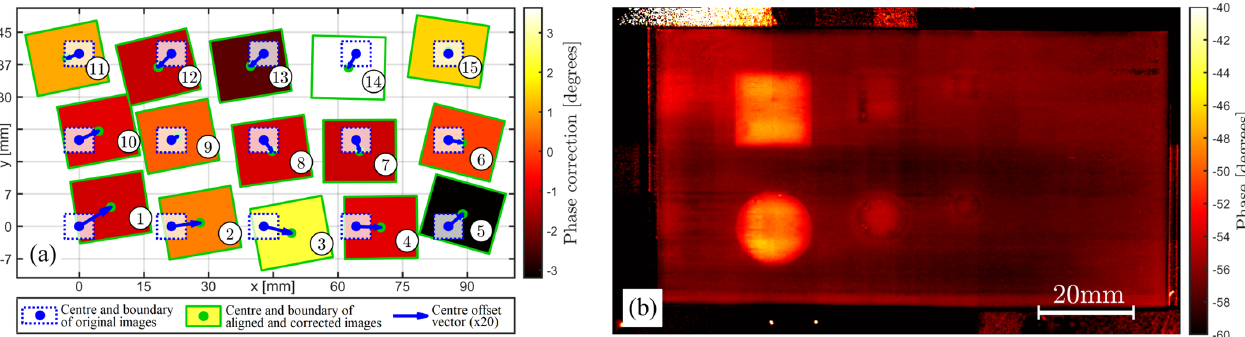
Figure 14. Execution times for alignment, pixel intensity correction and Laplacian blending.